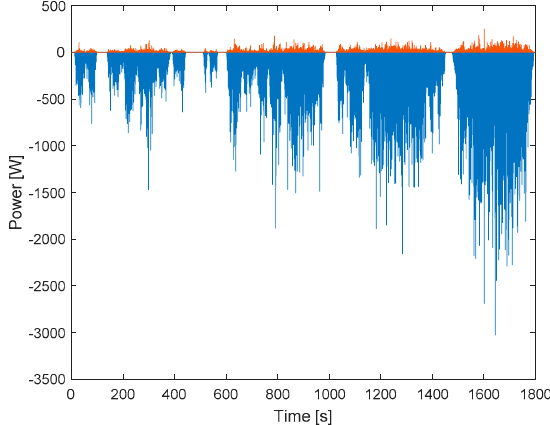
Figure 10. Power of regenerative suspension.